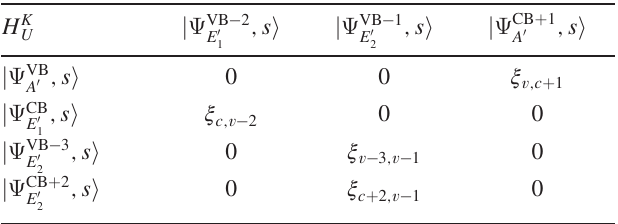
TABLE VI. Matrix elements of the external electric field at the K point between symmetric and antisymmetric states.